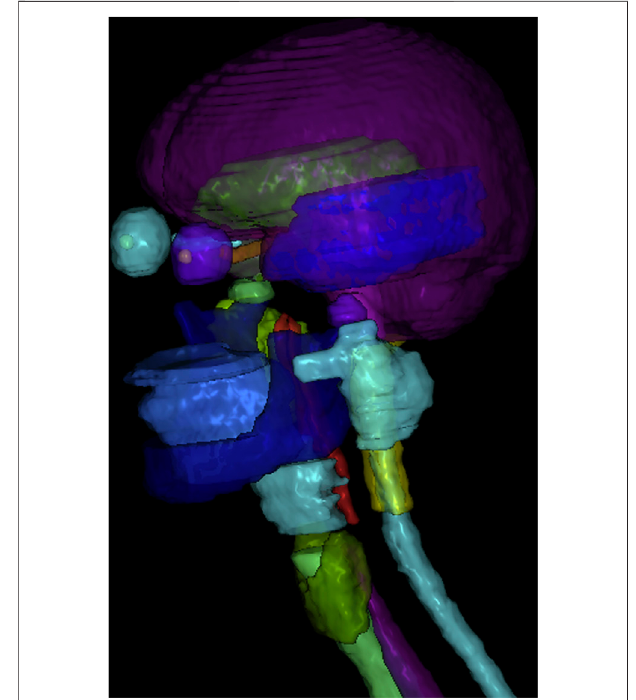
FIGURE 5 | 3-D display of SEB-Net-based auto-contouring for HaN